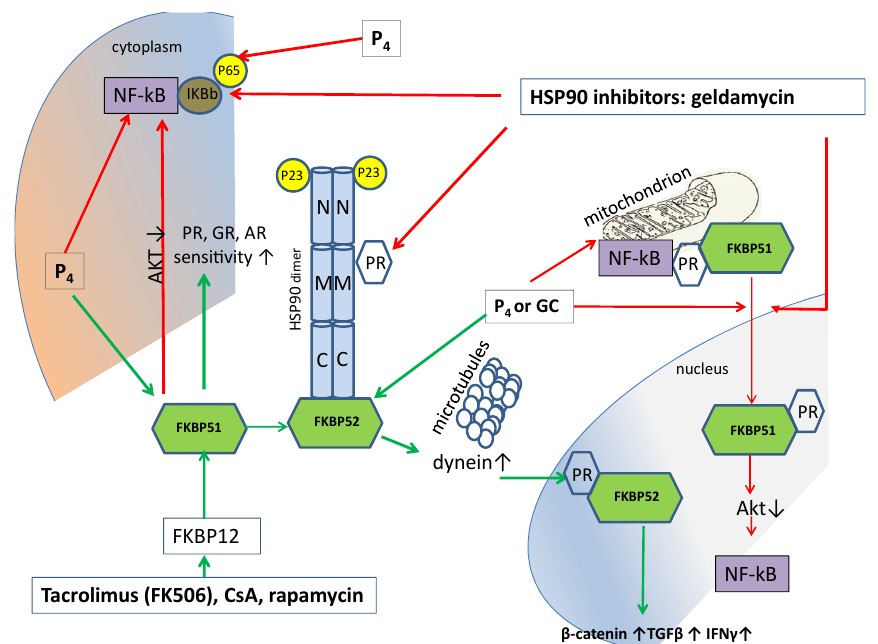
Figure 2. The probable mechanism of the P 4 -mediated PR and GR sensitization by FKBP-targeted drugs. Tacrolimus (FK506), CsA, and rapamycin bind FKBP12 and then inhibit FKBP51, which inhibits supplantation of FKBP52; in this way, FKBP52 does not induce dynein and disturbs FKBP52- mediated signaling ( β -catenin, TGF β , and IFN- γ ). Simultaneously, FKBP51 inhibits NF- κ B through an Akt-inhibitory mechanism. P 4 induces FKBP51, thus activating silenced PR, GR, and AR signaling. HSP90 inhibitors reduce the activation of FKBP52-mediated signaling. HSP90 inhibitors also decrease FKBP51 shuttling from the mitochondria to the nucleus; thus, NF- κ B is not activated in the nucleus. Red arrow—inhibition, green arrow—stimulation.